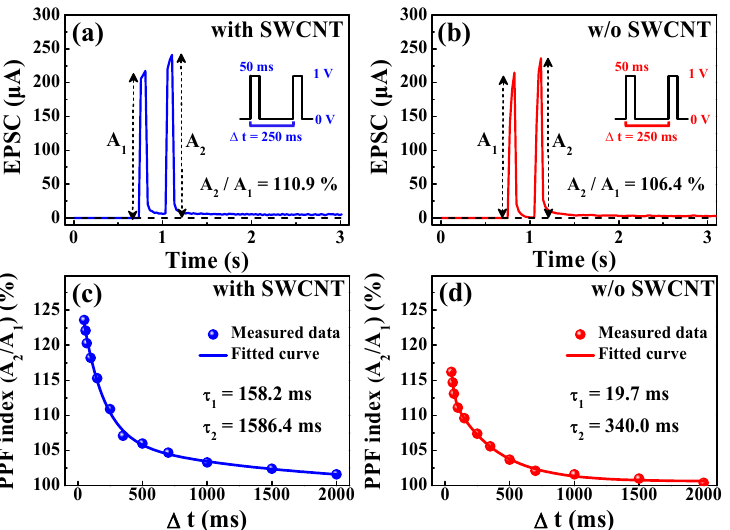
Figure 7. Triggered EPSC by PPF (amplitude: 1 V; duration: 50 ms; interval time: 250 ms) of chitosan memristors ( a ) with and ( b ) without SWCNT random networks. PPF indexes for chitosan memristors ( c ) with and ( d ) without SWCNT random